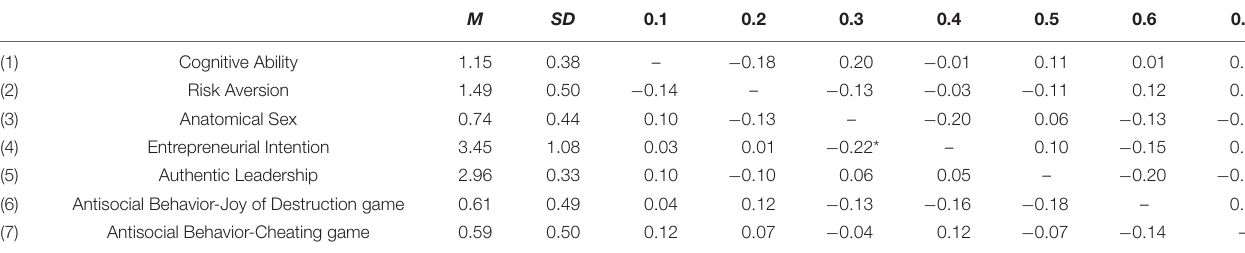
TABLE 1 | Phase 1 – Means, standard deviations, Kendall’s τ and Pearson’s r for all study variables.